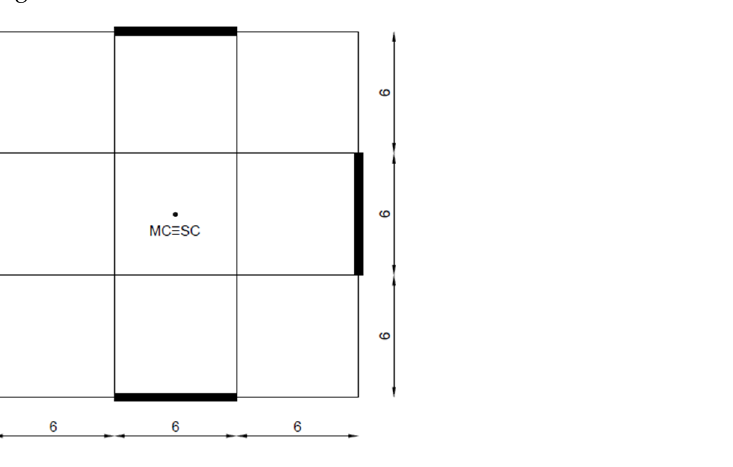
Figure 11. Plan of the one-floor building with the symmetrical CBF configuration (case studies 1 and 2).